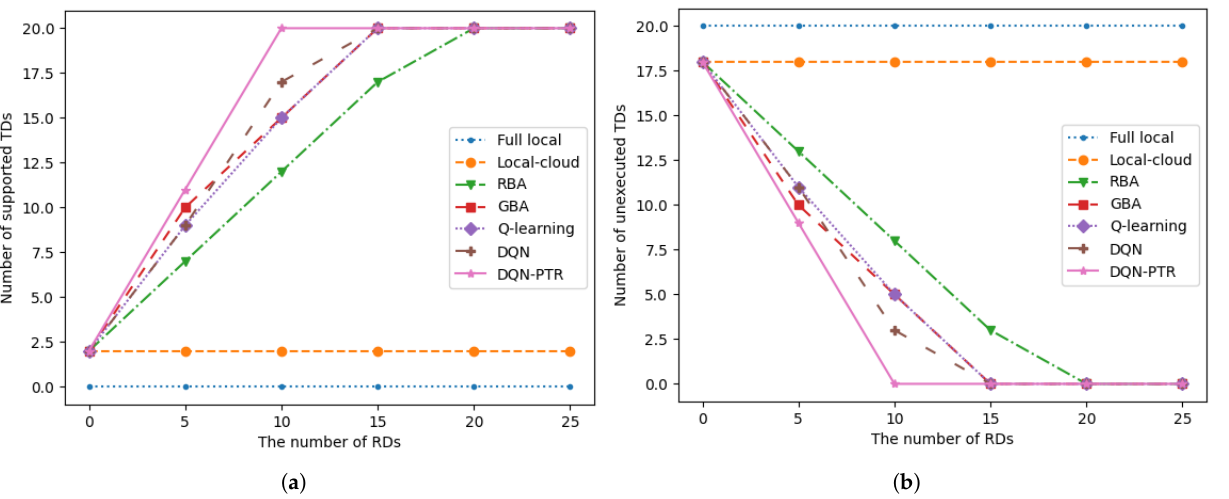
Figure 5. ( a ) The number of supported TDs versus the number of RDs. ( b ) The number of unexecuted TDs versus the number of RDs.